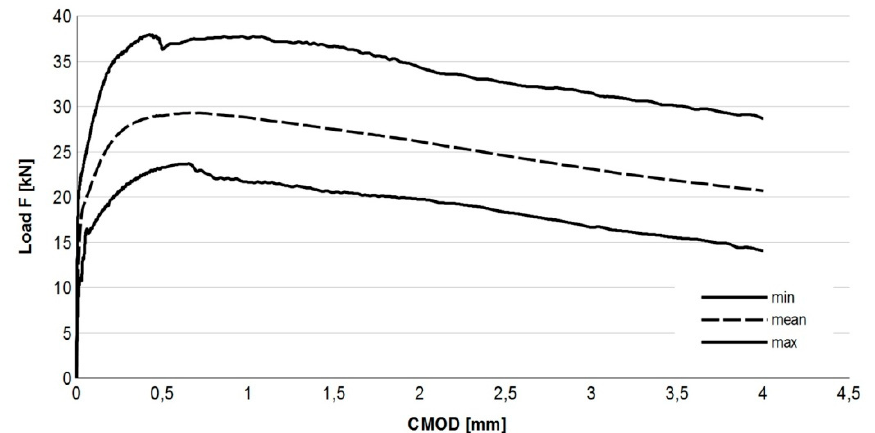
Figure 4. Load—CMOD relation for SFRWSC. Reproduced with permission from ref. [59]; published by Middle Pomeranian Scientific Society of the Environment Protection, 2015.